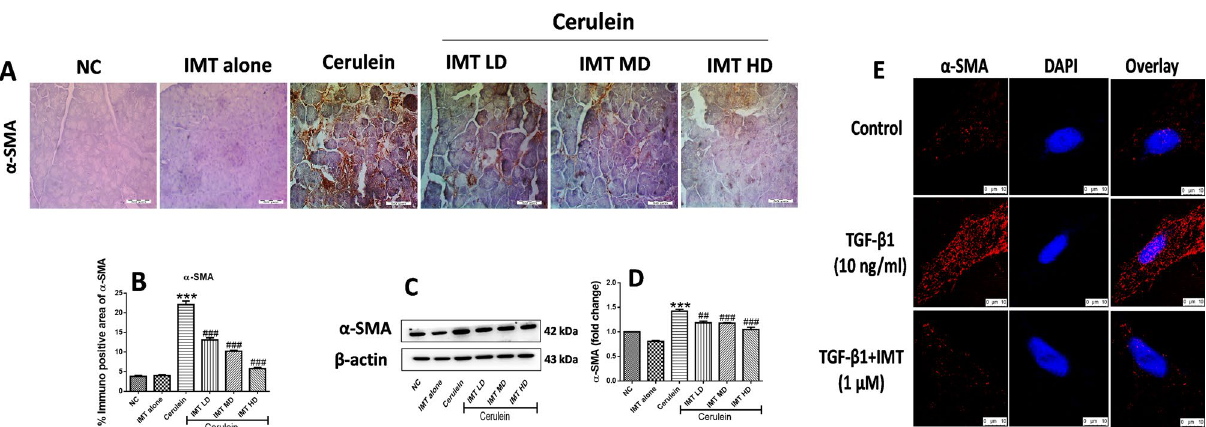
Figure 6. Effect of IMT on pancreatic stellate cells activation (PSCs). ( A,B ) Representative photographs of immunohistochemistry and quantitative analysis of α-SMA protein in the pancreatic tissue, ( C,D ) Western blot and corresponding densitometric analysis of protein expression of α-SMA, ( E ) Immunofluorescence (IF) staining for α-SMA in TGF-β1-induced PSCs. β-actin was used as loading control. All values are represented as mean ± SEM (n = 3–10). Statistical significance was established using one-way ANOVA followed by Tukey’s multiple comparisons test where ***P < 0.001 vs Normal control, ## P < 0.01, ### P < 0.001 vs Cerulein. Full-length blots are presented in Supplementary Fig.